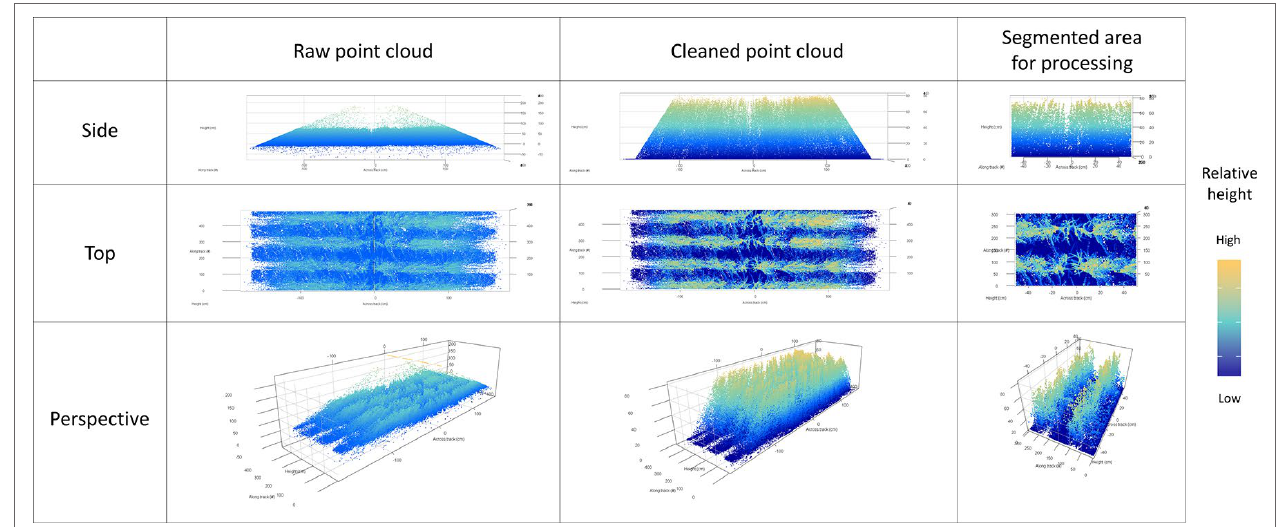
FIGURE 2 | Visualisation of a point cloud collected in the current study (at Zadoks growth scale 65), showing the three steps of data processing; raw point cloud, cleaned point cloud, and segmented area used for processing of measurements, from a side, top and perspective